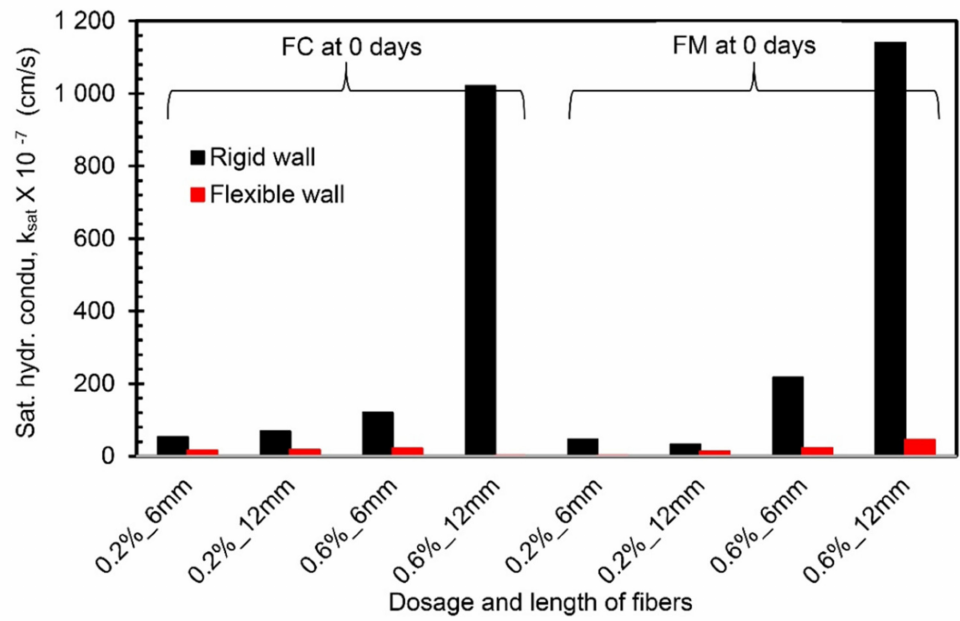
Figure 9. Comparison of hydraulic conductivity values from FWP and RWP (0-day curing